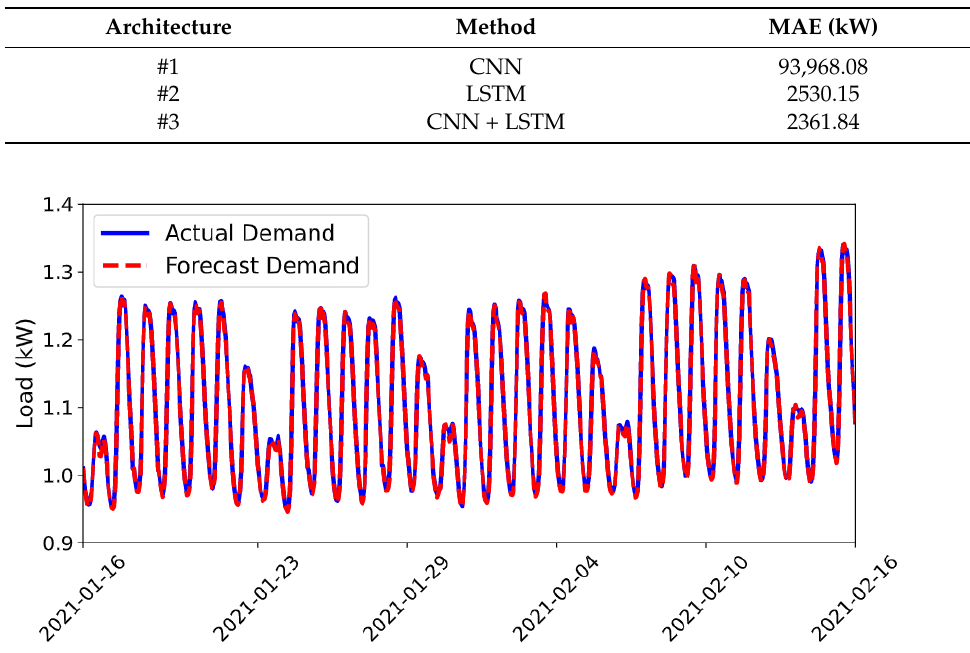
Figure 6. Demand prediction curve for architecture #3. The blue line is the actual demand value and the dashed red line is the predicted demand the dashed red line is the predicted demand value.